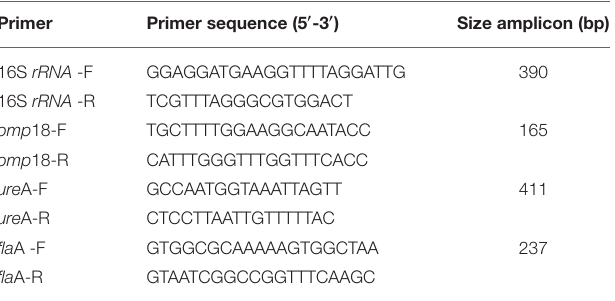
TABLE 1 | Primers used for RT-PCR targeted to Helicobacter pylori